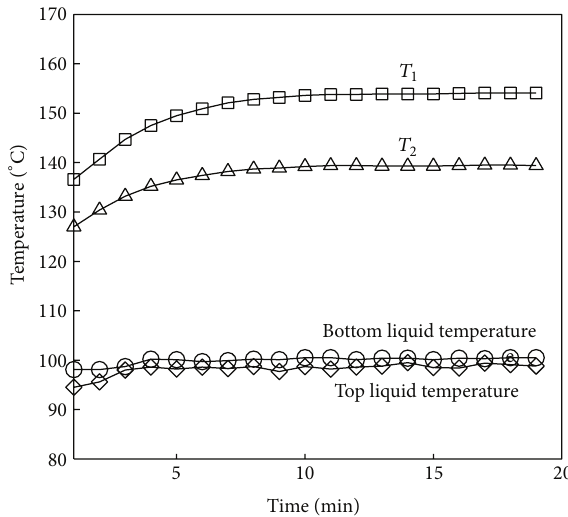
Figure 5: Temperature curves for one heat flux experiment.